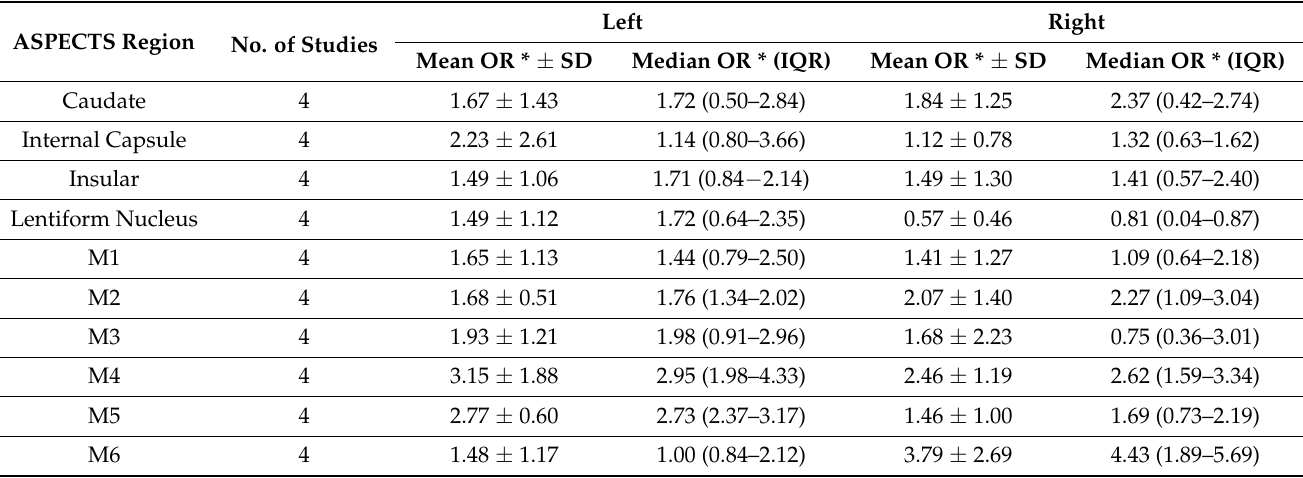
Table 5. Summary of mean and median of ORs for infarcts in 10 ASPECTS regions, stratified by laterality, with functional outcomes at 90